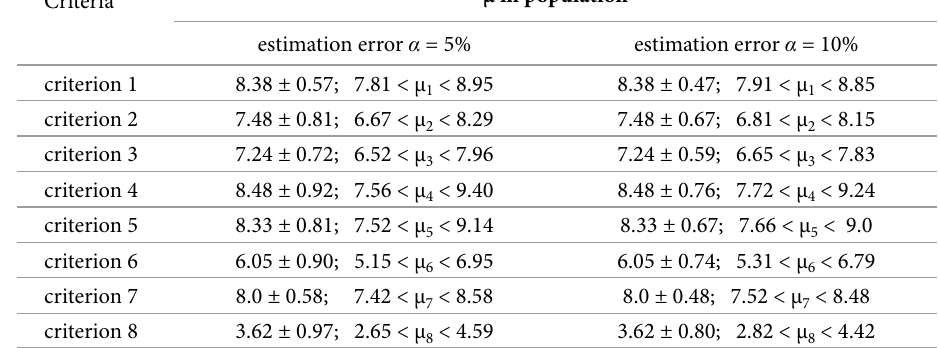
Table 4. Limits of confidence intervals of the value of average importance for particular criteria Confidence intervals for average x of the sample and for average μ in Criteria